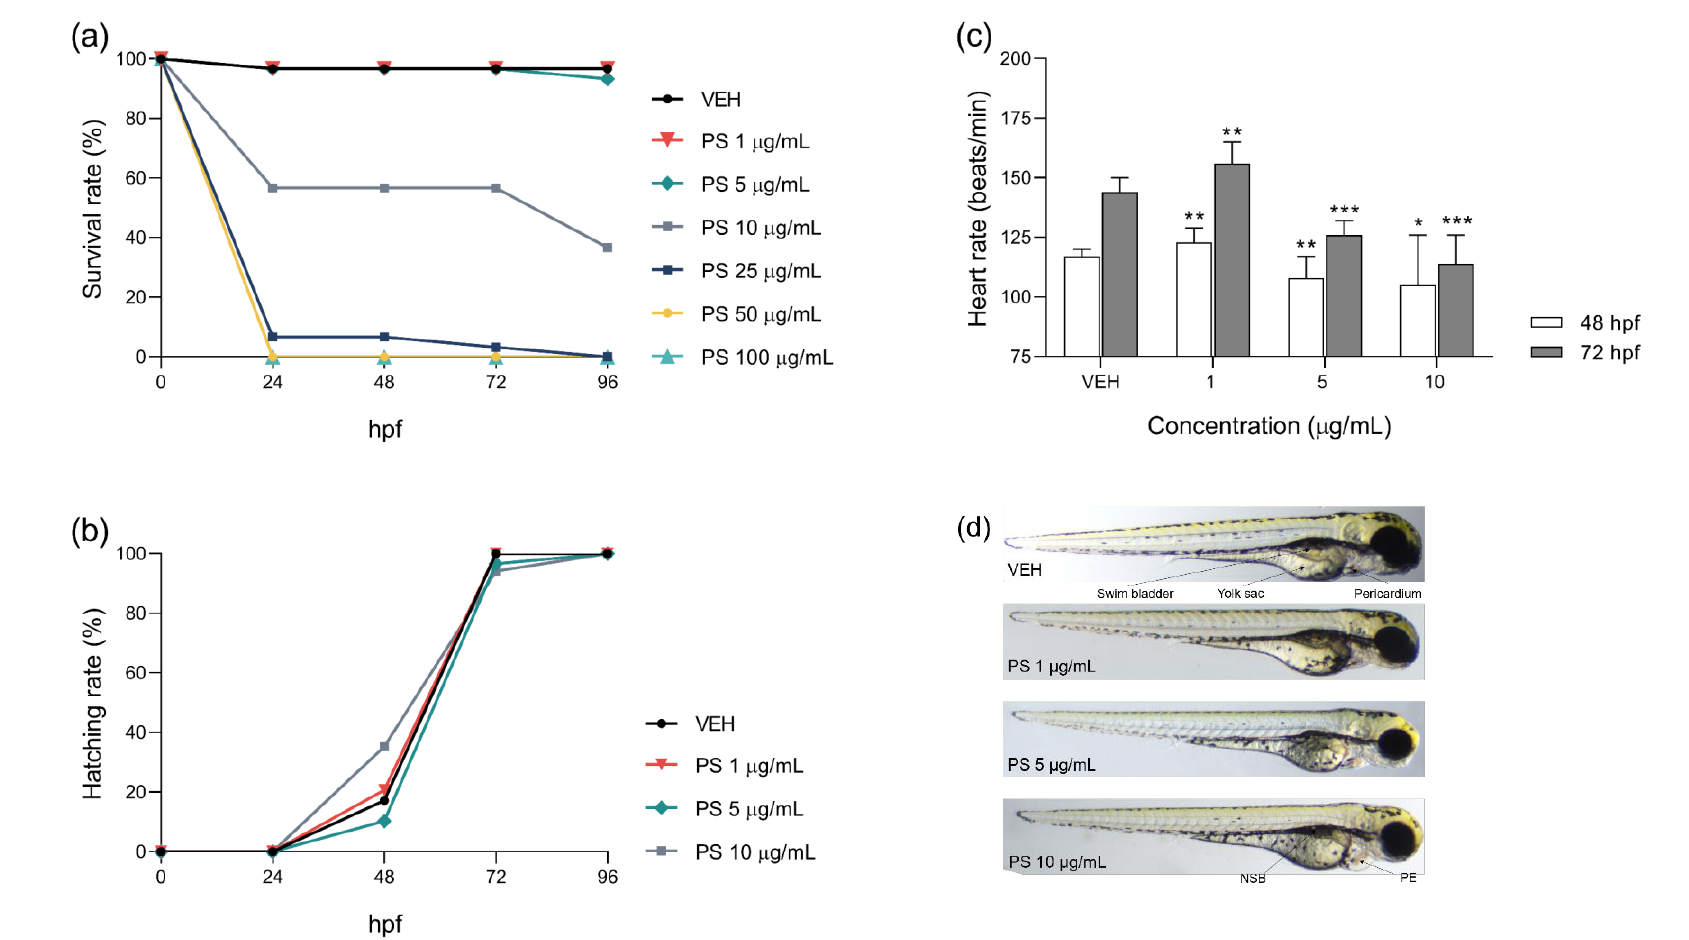
Figure 3. Survival ( a ) and hatching ( b ) rates for zebrafish embryos exposed to protamine sulfate (PS) concentrations or vehicle (VEH) from the 2nd to 96th hour post–fertilization (hpf). Heart rate ( c ) values of zebrafish embryos and larvae at 48 and 72 hpf. Morphology ( d ) of zebrafish larvae at 72 hpf. Abbreviations: NSB, non–inflated swim bladder; PE, pericardial edema. Data are shown as medians with ranges. Note: * p < 0.05; ** p < 0.01, *** p < 0.001 vs. VEH within the group, Kruskal–Wallis ANOVA with Dunn’s post–hoc test, n = 17–29 for each concentration.